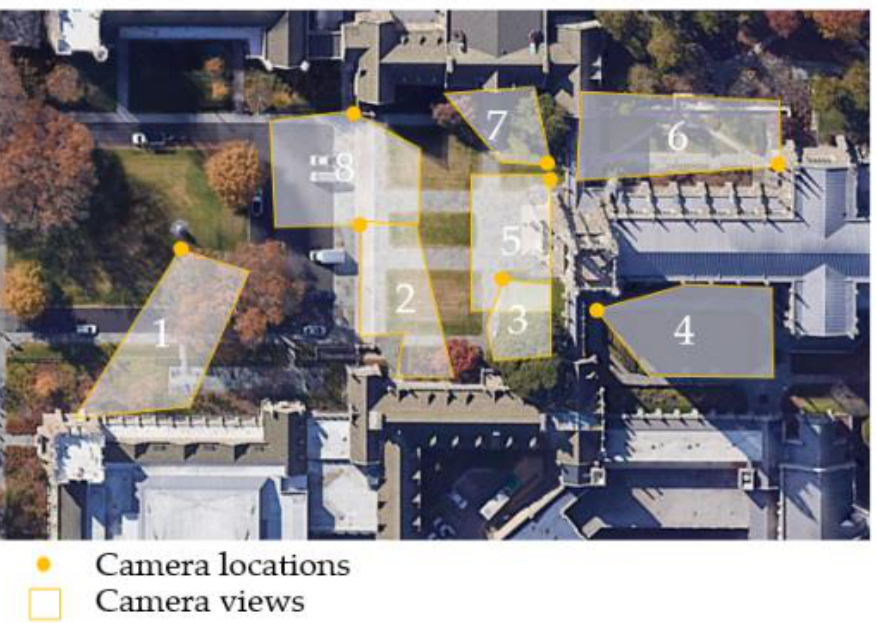
Figure 1. The DukeMTMC dataset with 8 disjoint camera views. Satellite image source: Google Earth.